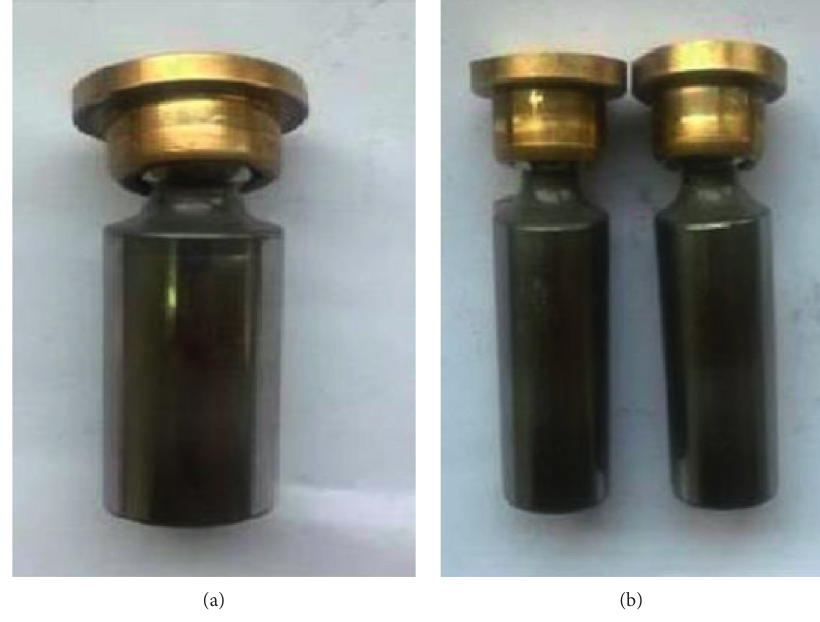
Figure 6: The fault types of plungers. (a) Plunger loose slipper. (b) Piston shoe wear.